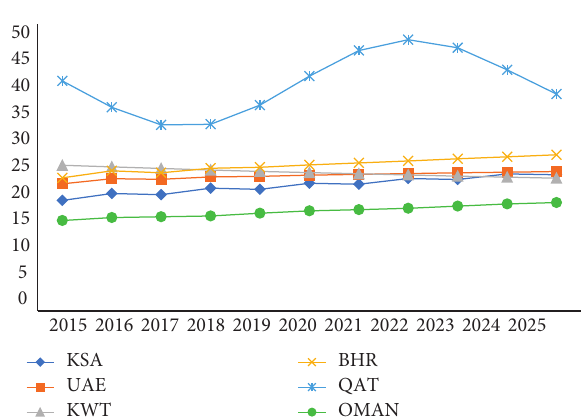
Figure 4: Predicted value of CO 2 emissions (metric tons per capita) using the ARIMA (2,1,2)